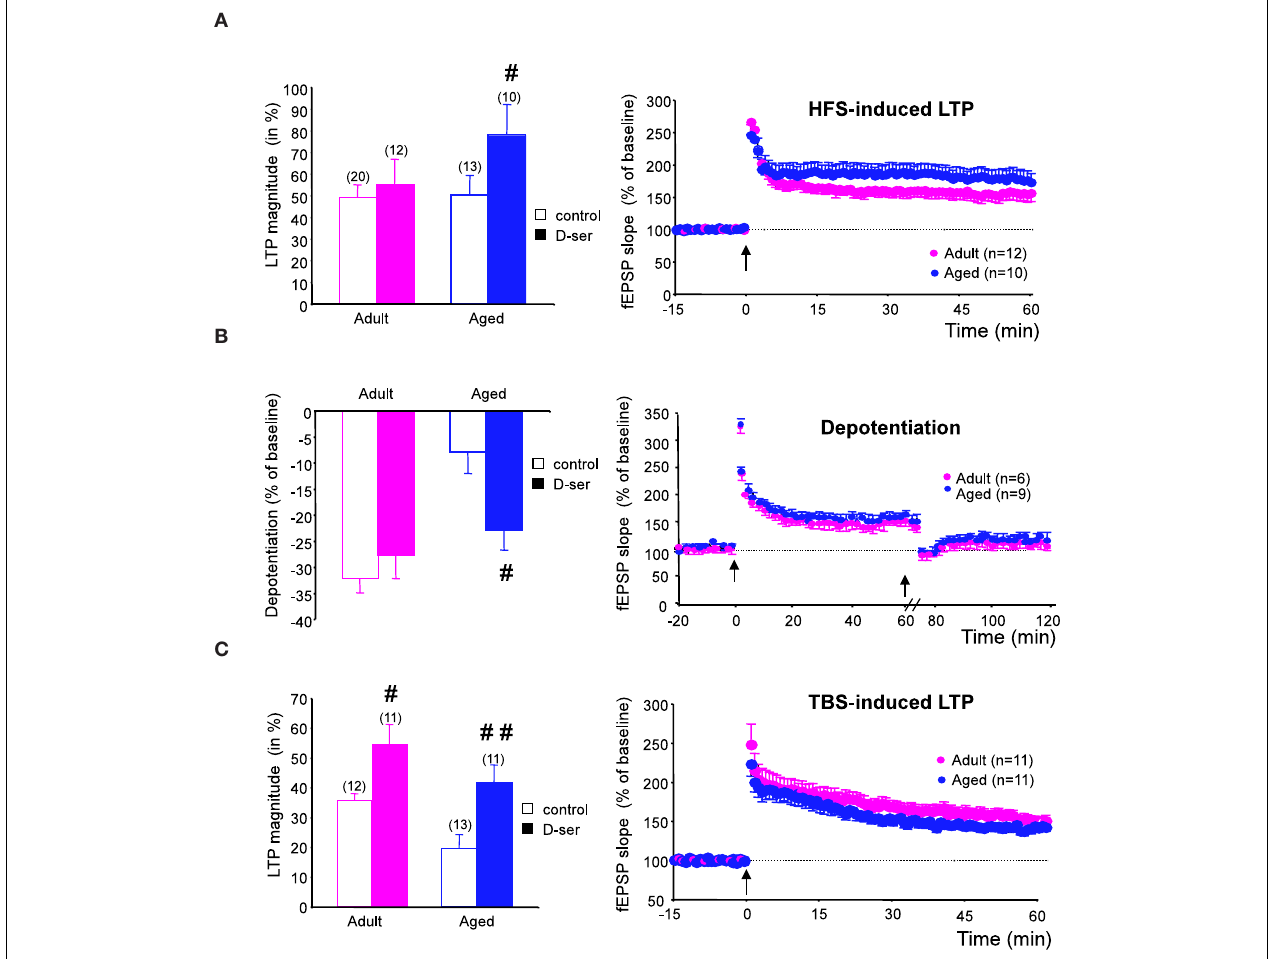
FIGURE 3 | D -serine alleviates the age-related defi cit in synaptic plasticity. ( A , left) Effects of D -serine (100 µM) on the magnitude of HFS-induced LTP calculated for the last 15 min of recording. ( A , right) Time-course of LTP induced